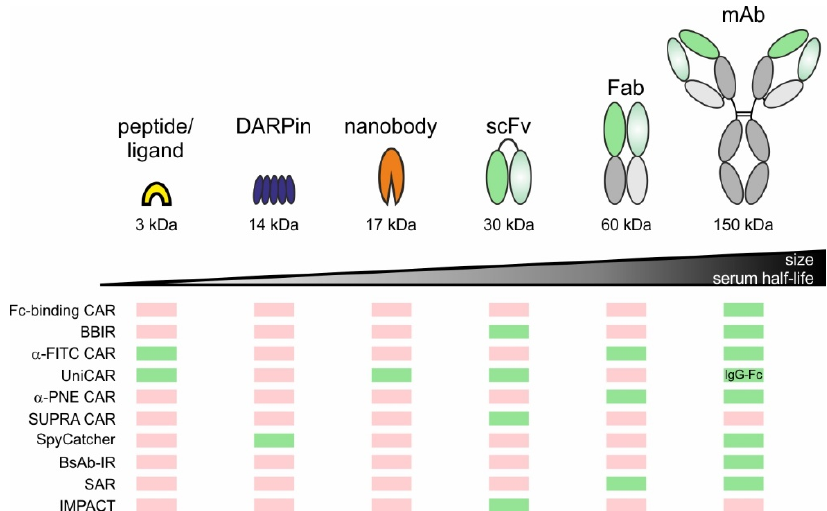
Figure 3. Binding moieties used for adaptor molecule design. Overall, small peptides/ligands, Designed Ankyrin Repeat Proteins (DARPins), nanobodies derived from camelid antibodies, single-chain fragment variables (scFvs), fragments of antigen binding (Fabs), and full size monoclonal antibodies (mAbs) were used to engineer adaptor molecules. Boxes below indicate whether or not the binding moiety was already applied to a certain adaptor CAR platform (green: yes; red: no).